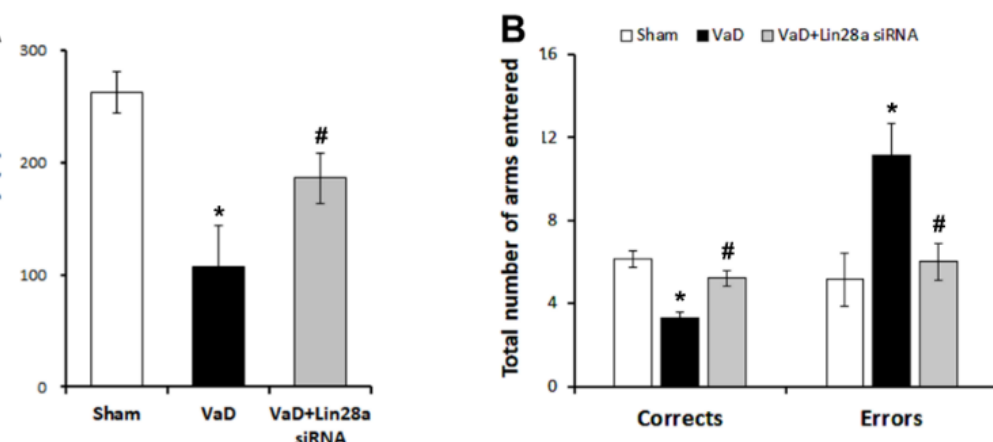
Figure 5. Effect of blocking Lin28a on VaD-induced cognitive impairment using passive avoidance and radial 8-arm maze tests. ( A ) In the passive avoidance test, VaD+Lin28a siRNA group show significantly improved latency times compared to the VaD group ( B ) In the radial 8-arm maze test, VaD+Lin28a siRNA group show significantly improved number of correct and errors choices compared to the VaD group. The data are presented as the mean ± S.E.M. * p < 0.05, compared to the sham group. # p < 0.05, compared to the VaD group.